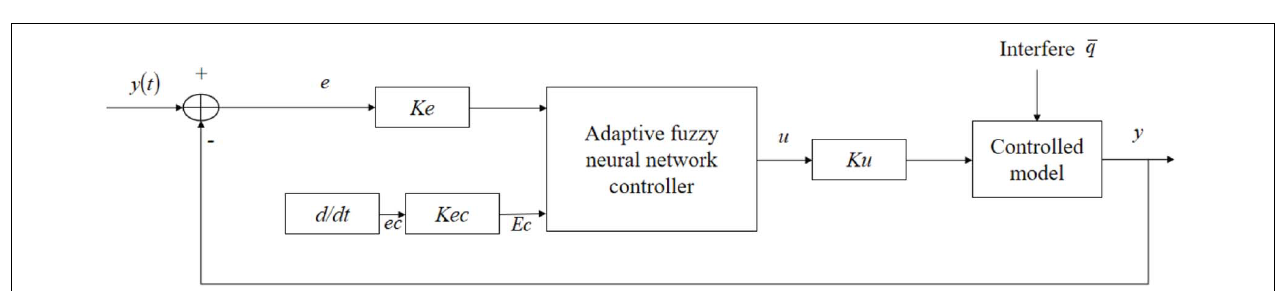
FIGURE 3 | Fuzzy neural network control simulation